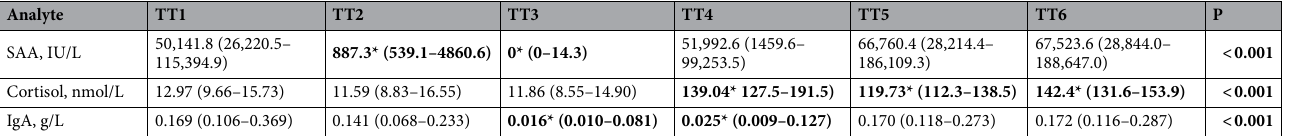
Table 2. Effect of inactivation protocols in salivary stress biomarkers [median (25–75 percentile)]. Significant values are in bold. *P < 0.05. Control (TT1); 65 °C 30 min (TT2); 92 °C 15 min (TT3); SDS (TT4); NP40 (TT5) and triton (TT6).